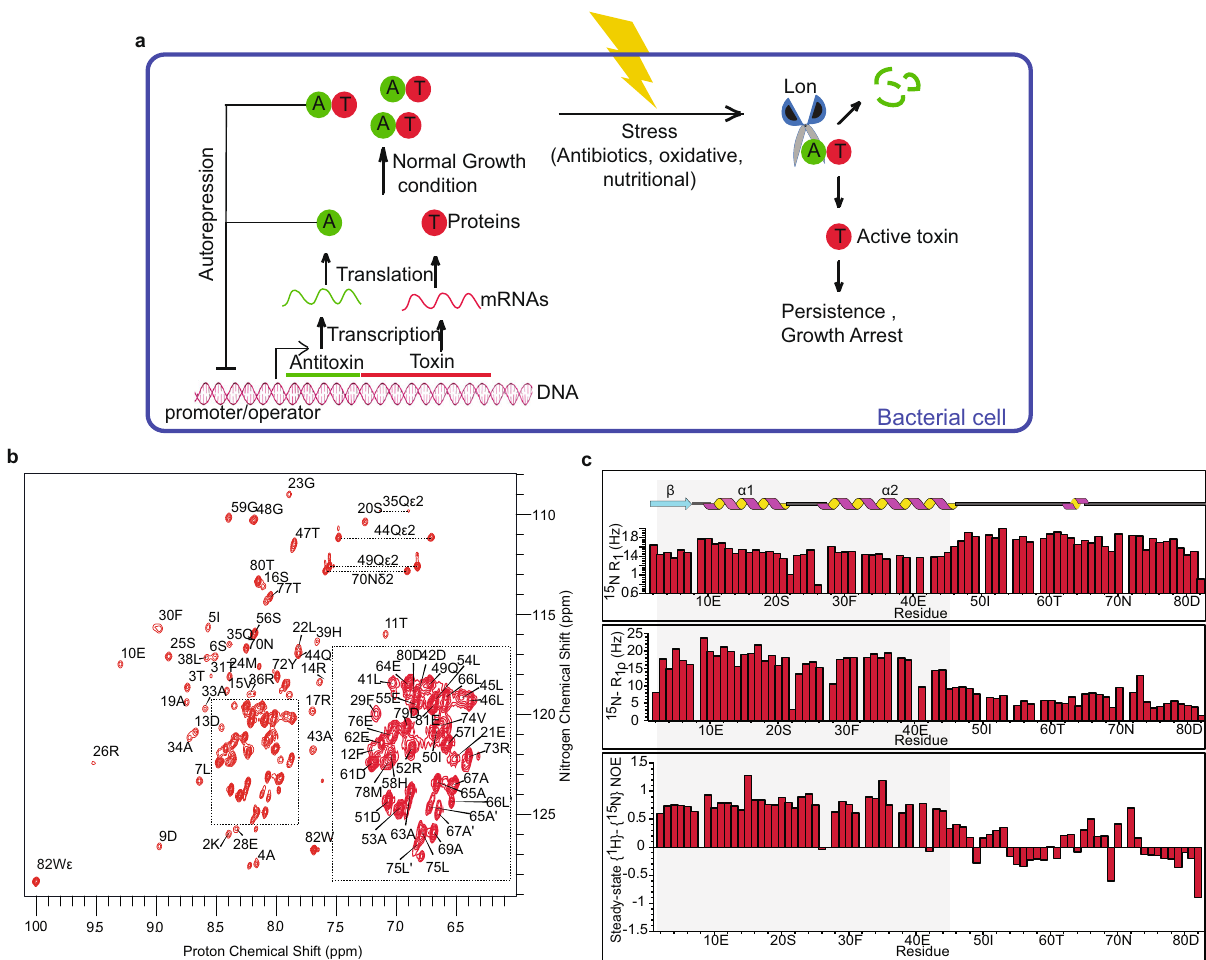
Fig. 1 NMR characterization of MazE6. a Schematic representation of working mechanism of Type II TA system. b Sequence speci fi c assignments are indicated on the 2D 1 H- 15 N HSQC spectrum of MazE6. Inset shows the assignment for the crowded region of the spectrum within the box. Assignments with a prime superscript ( ′ ) represents doubling of peaks due to conformational heterogenity. Horizontal dotted lines connect resonances of side chain amide protons. See text for details. c R 1 , R 1 ρ relaxation rates and steady-state heteronuclear { 1 H} - 15 N NOEs for 15 N backbone nuclei of MazE6, plotted against residue number. Low R 1 ρ relaxation rates and steady-state { 1 H} - 15 N heteronuclear NOE values for the C-terminal residues further con fi rm its disordered (dynamic) nature in solution. Blank spaces correspond to residues for which data is missing. Source data are provided in the Supplementary Data were possible for 93.75% H N , 70.17% 15 N, 100% 13 C α , 75.6% CO